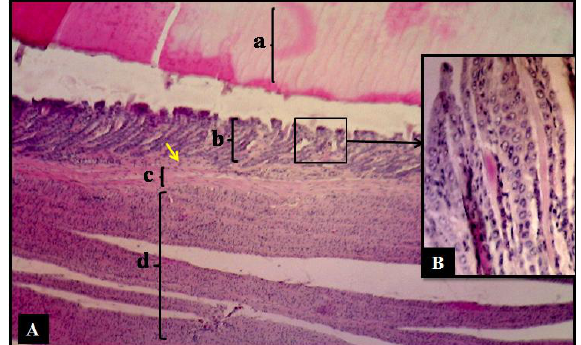
Figure, 4: A. Ventriculus wall of pigeon cuticle (a), mucosa (b), submucosa (c), muscularis (d), muscularis mucosa (yellow arrow), (H and E, X100). B. showed higher magnification of epithelial cells in the mucosa, (H and E, X400).